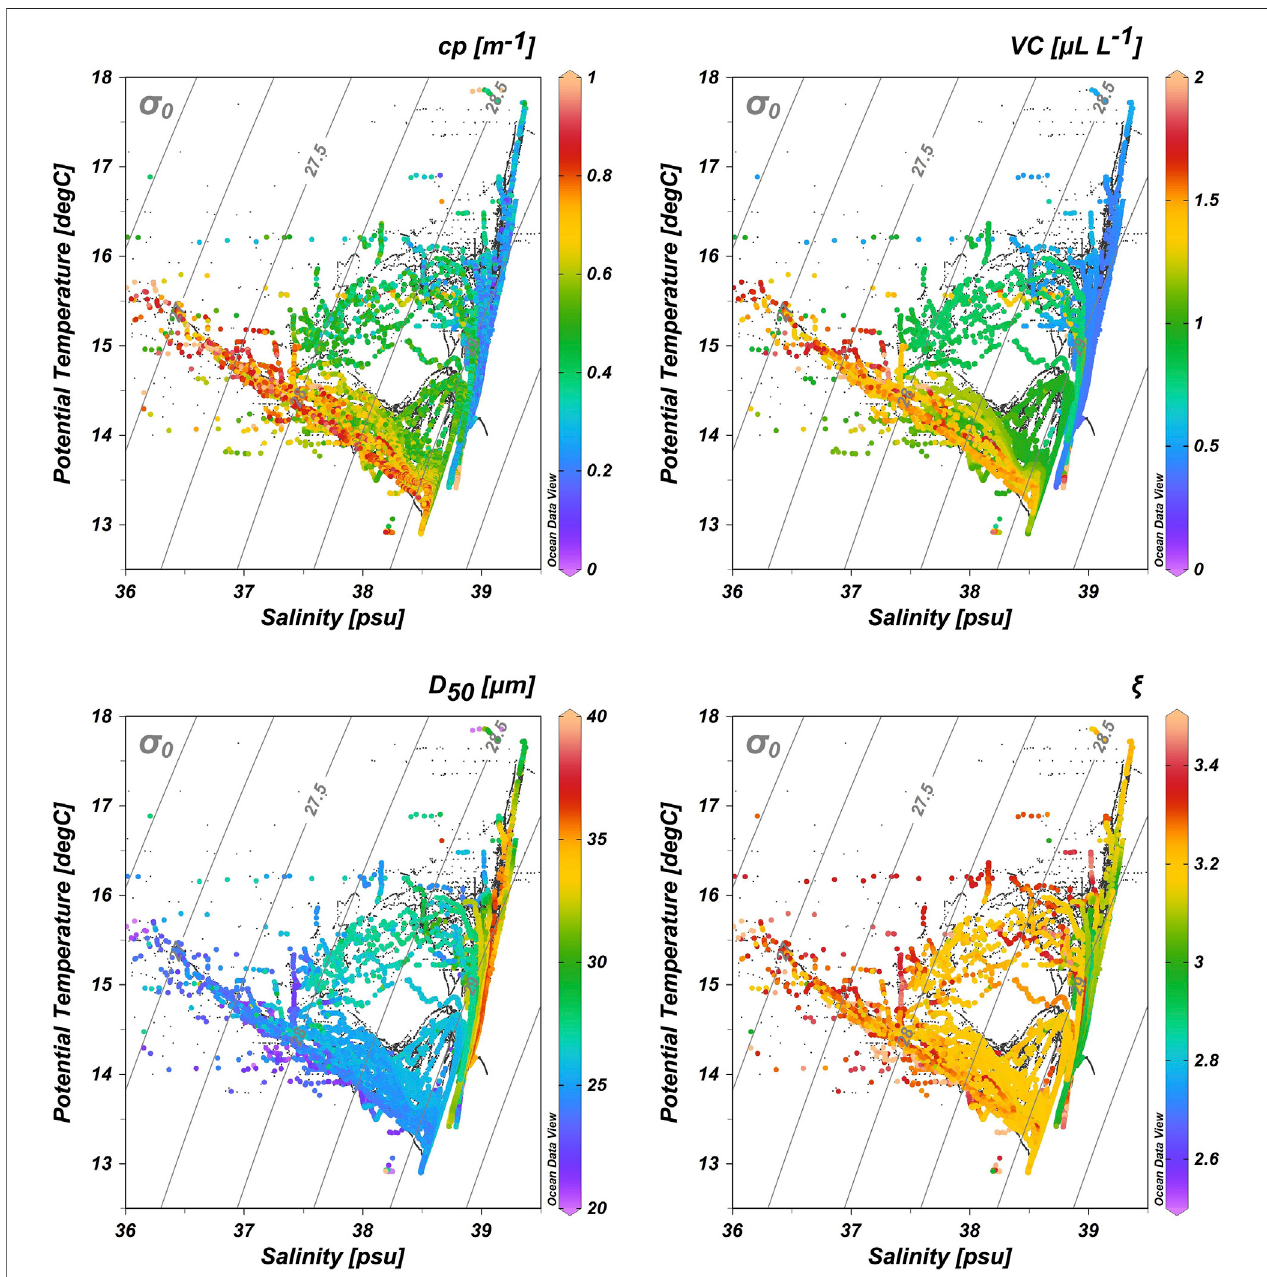
FIGURE6| Theta-SdiagramofthestationssampledduringtheMSM72cruisesuperimposedwithc p ,VC,D 50 and ξ data.Abbreviationsofopticalparametersand main water masses are de fi ned in the text.